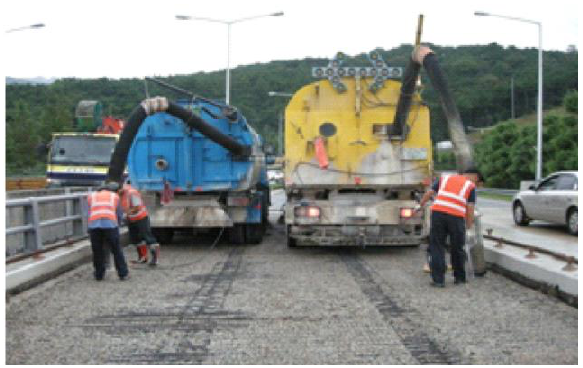
Figure 11. Bridge overlay site.